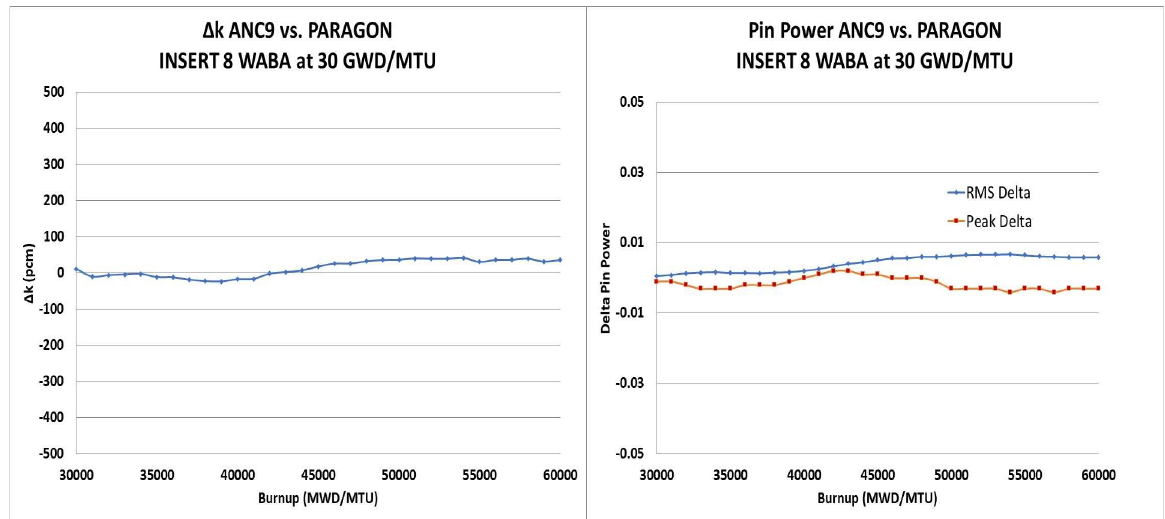
Figure 3. Comparison of eigenvalue and pin power for 8 WABA insert at 30 GWD/MTU